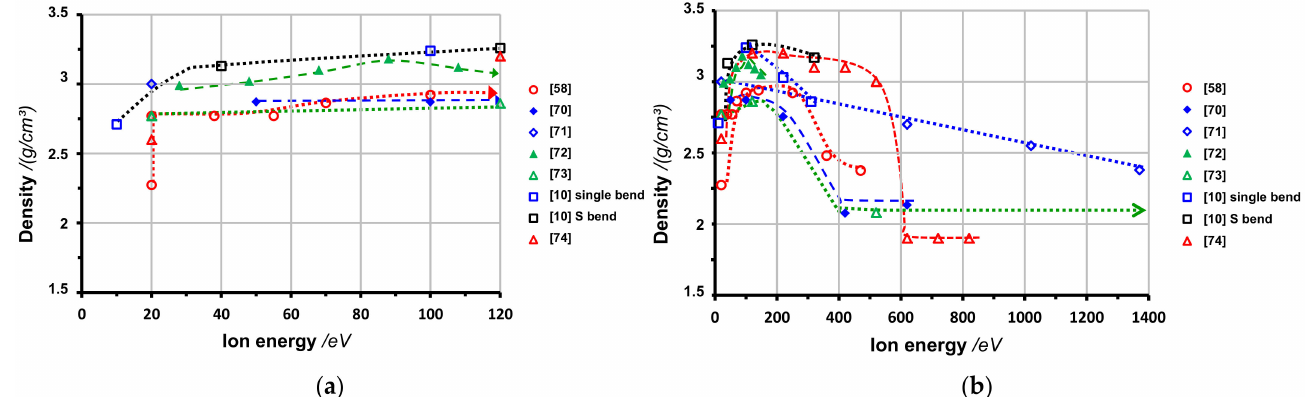
Figure 11. Dependence of the density on the ion energy for carbon films, deposited by filtered vacuum arc. (Density from plasmon peak according to Equation (5), [74]: from X-ray reflection (XRR)). dc arc: [10,58,70–72], pulsed arc: [73] (300 A/5 ms, pulsed bias 2 µ s on, 6 µ s off), [74] (1600 A/300 µ s, synchronized bias). Empty symbols: Ion energy for 0 V bias estimated by 20 eV. ( a ) Medium energy range. ( b ) Extended energy range.